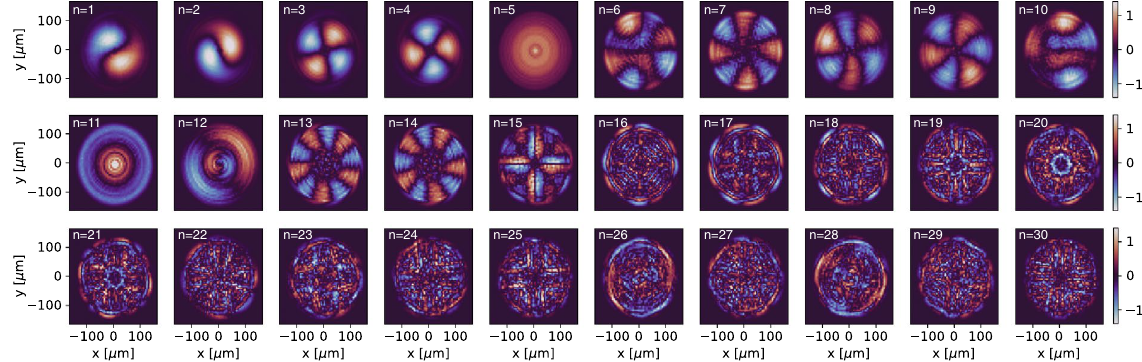
Figure 4. The first 30 principal components (normalized) of the input electron beam distribution are shown. The most dominant modes are n = 1 to n = 15 , after which the components are seen to represent very fine